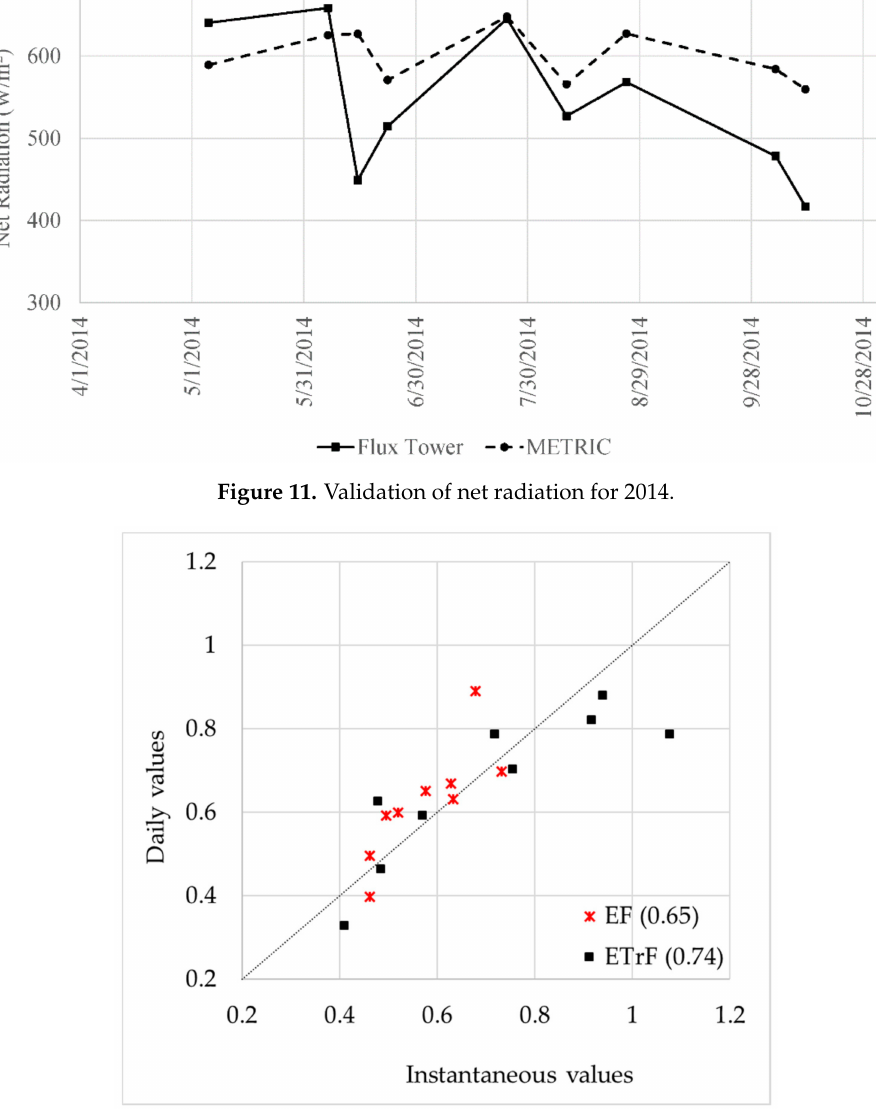
Figure 12. Comparison between instantaneous and daily Evaporative Fraction ( EF ) and Reference ET fraction ( ETrF ) computed using flux tower energy balance components. r 2 values are presented in